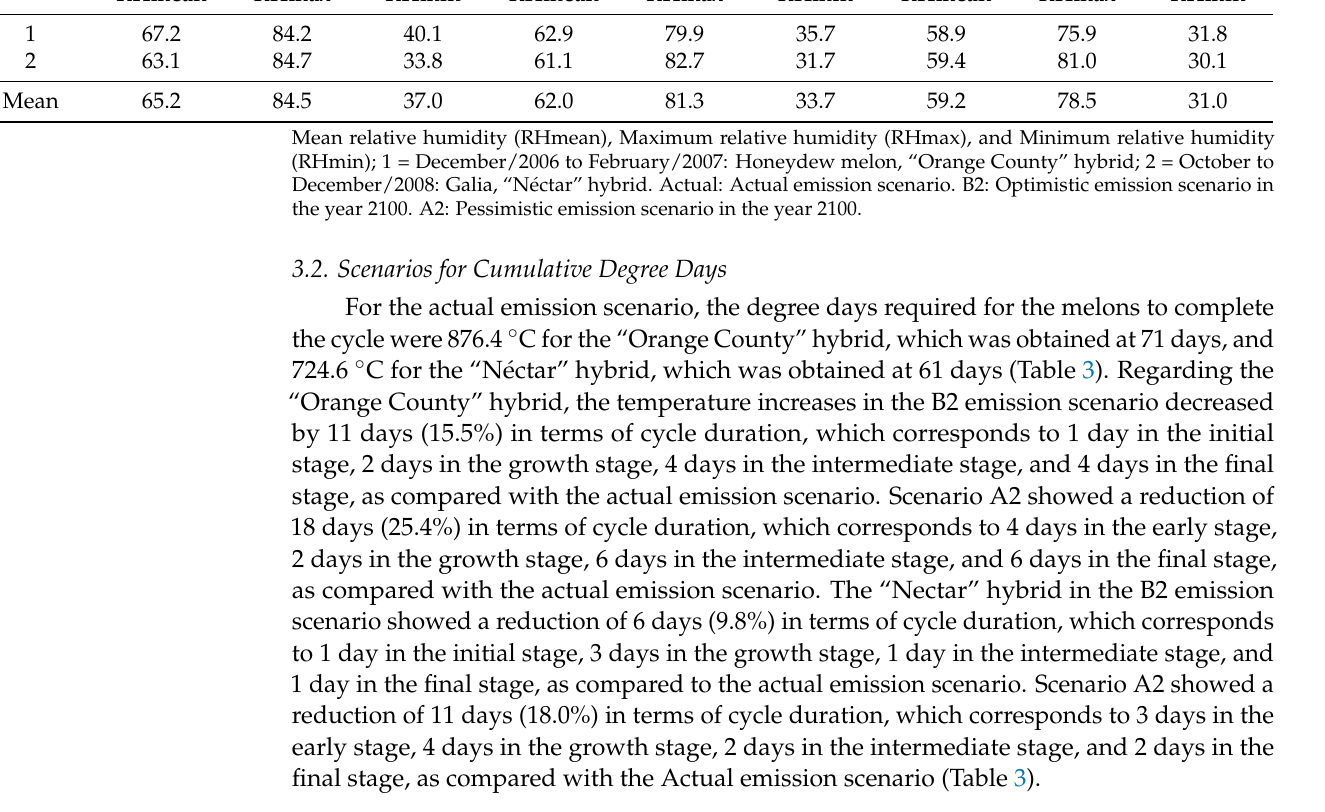
Table 3. Melon cultivars’ cumulative degree days (CDD) and phenological stage durations for the Intergovernmental Panel on Climate Change’s emission